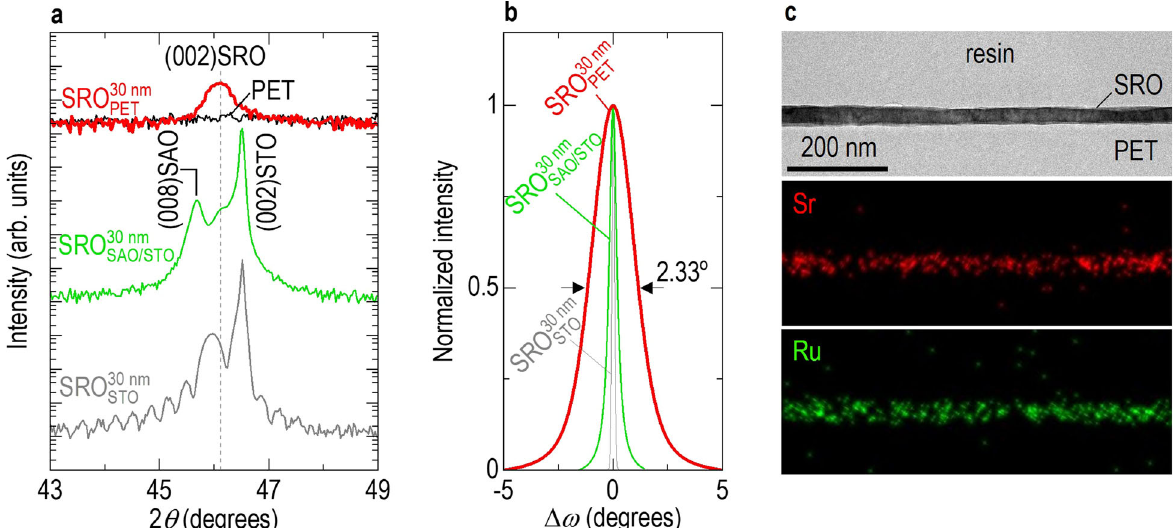
Fig. 4 Preservation of the single crystallinity of the SRO fl exible membranes. a X-ray diffraction θ − 2 θ scans show the (002) diffraction peaks of SRO near 2 θ = 45.9 − 46.1°, as guided by a dashed line, for SRO 30nm sacri fi cial layer and the SrTiO 3 substrate, respectively. b Full widths at half maximum of the normalized ω scan increased from 0.14° ð SRO 30nm Þ . For convenience, we used the normalized intensity ð¼ I to 2.33° ð SRO 30nm PET c Scanning transmission electron microscopy images show few mechanical fractures over a wide area of SRO 30nm spectroscopy measurements indicate a uniform distribution of Sr and